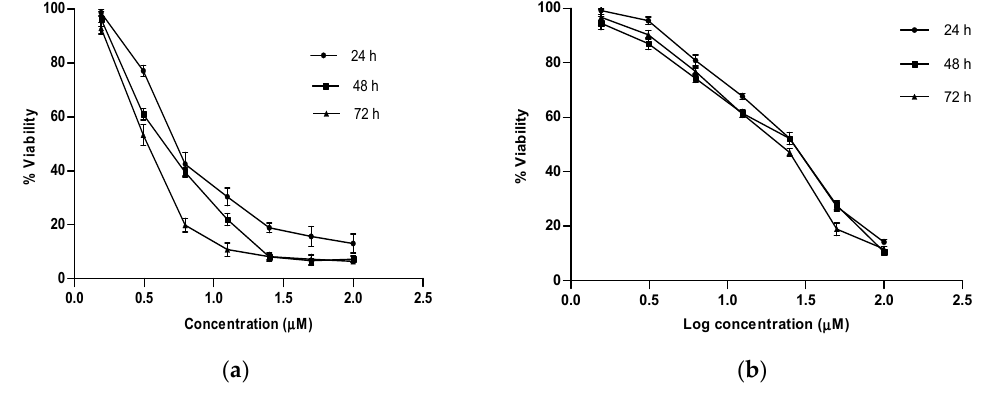
Figure 4. Dose–response curves of time-interval effect for: ( a ) Artonin E and ( b )Tamoxifen on MCF 7. Table 5. IC 50 Values of Artonin E and Tamoxifen on MCF 7 at Different time interval. Compounds